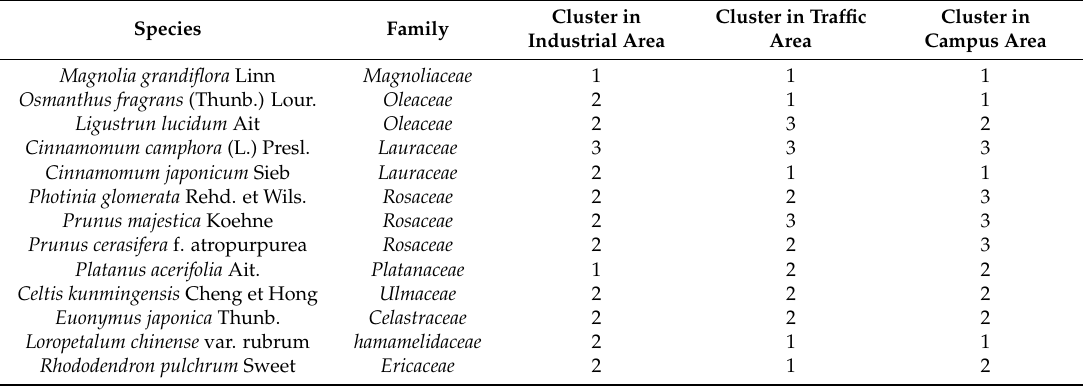
PM concentrations of cluster 1 in industrial, traffic and campus areas were >5.22 g m −2 , >2.35 g m −2 and >1.4 g m −2 , respectively; those of cluster 2 were 1.24–5.22 g m −2 , 1.05–2.35 g m −2 and 0.67–1.4 g m −2 ,